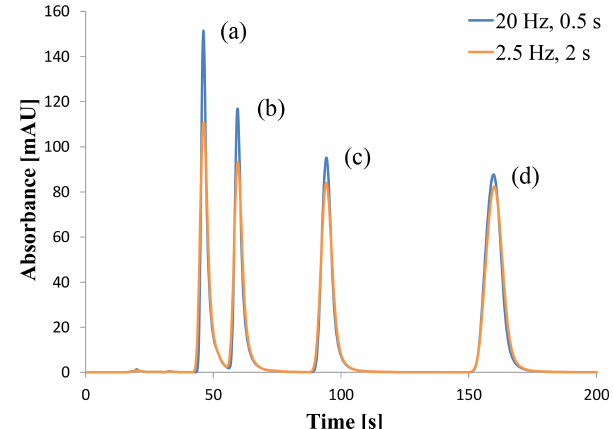
Figure 4. Signal deviation as the difference between OpenLab ChemStation ® and Second Controller Instance when using sam- pling rates of 20Hz (0.5s response time) and 2.5Hz (2s response